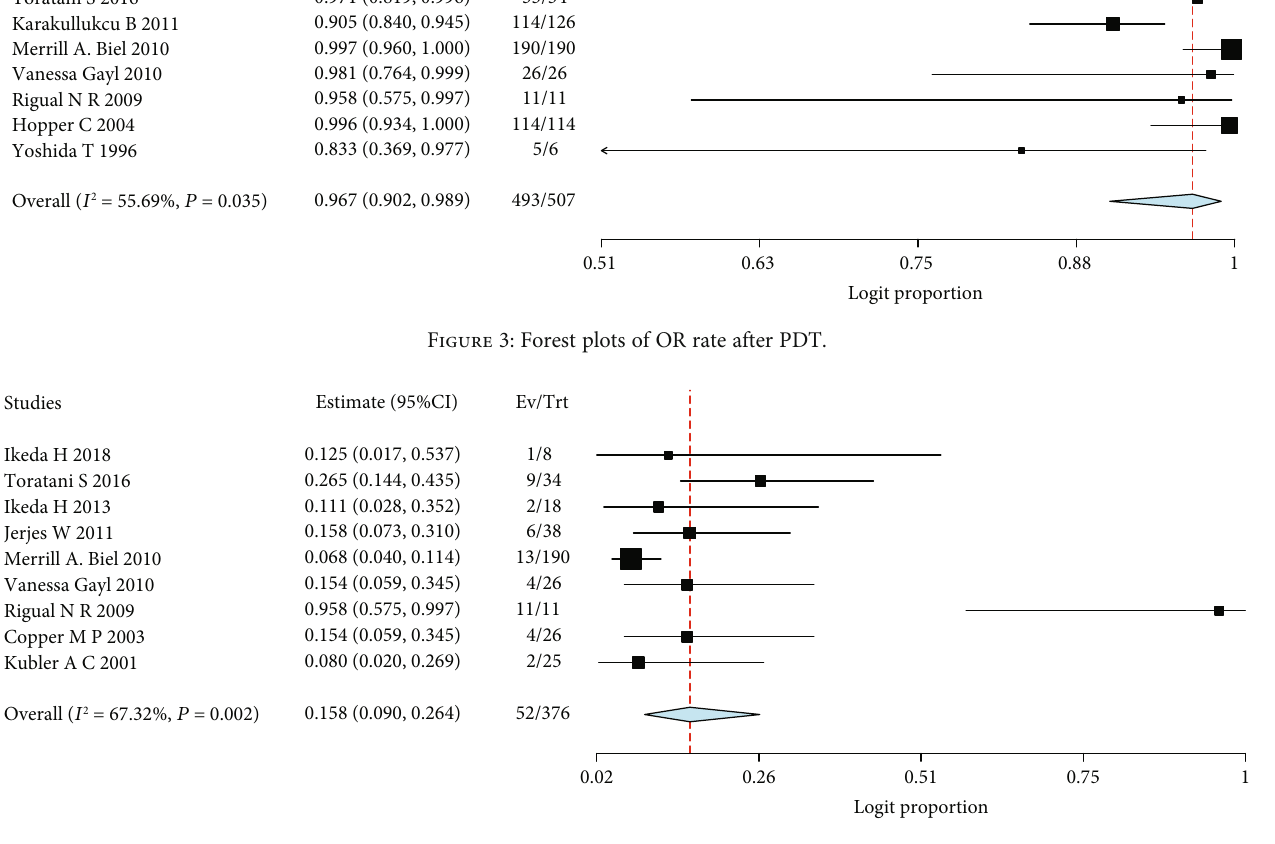
Figure 4: Forest plots of proportions of RR after PDT.